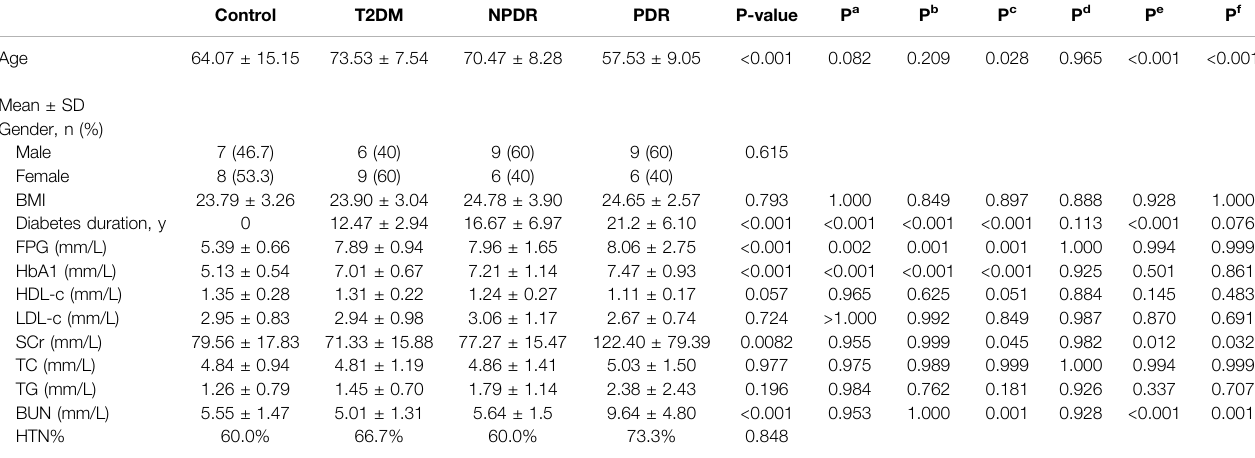
TABLE 1 | Demographics, comorbidities, and serum test results across groups. Control